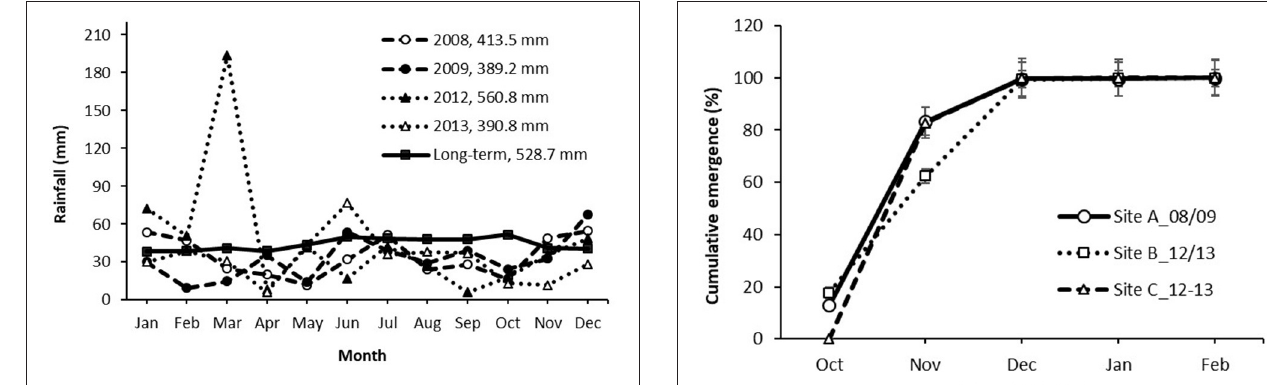
FIGURE 5 | Annual rainfall in years 2008, 2009, 2003, and 2013 as compared with the long-term average (115 years).